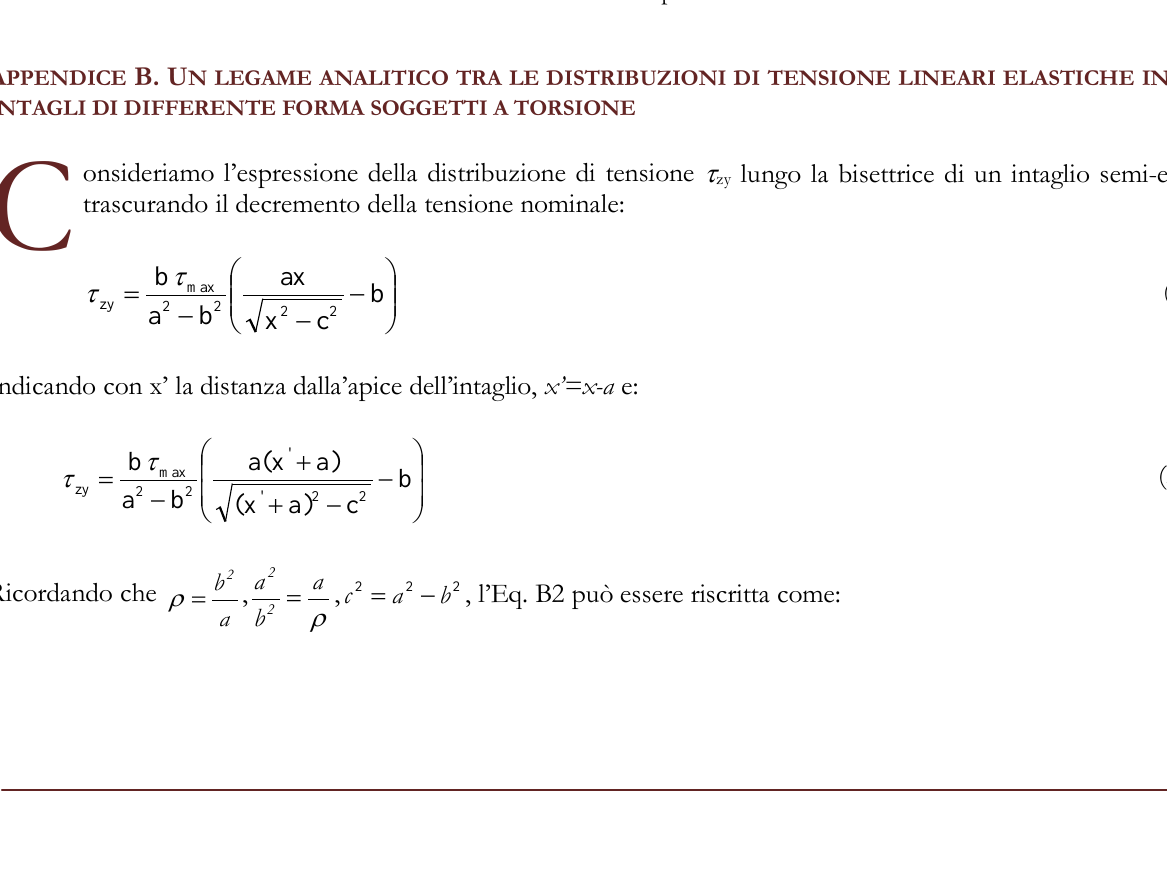
Figura A2 : Componenti di tensione Le tensioni sono normalizzate rispetto alla tensione